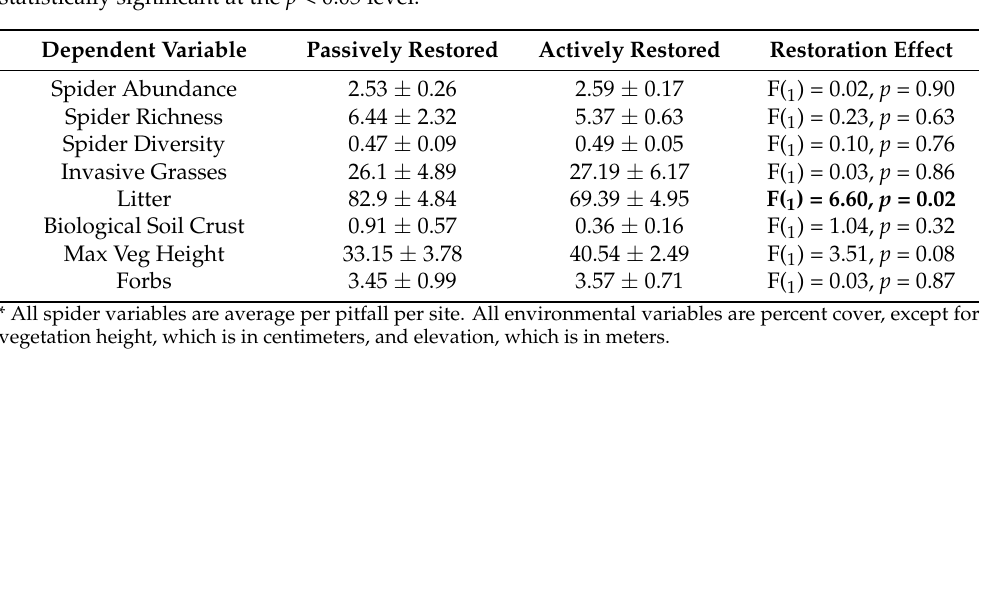
Table 4. Mean ( ± SE) spider abundance, rarefied richness, and Shannon diversity and environmental variables in passively and actively restored sites located in three grasslands in the Pacific North- west, and the restoration effect using ANOVA blocked by location. Restoration effects in bold are statistically significant at the p < 0.05